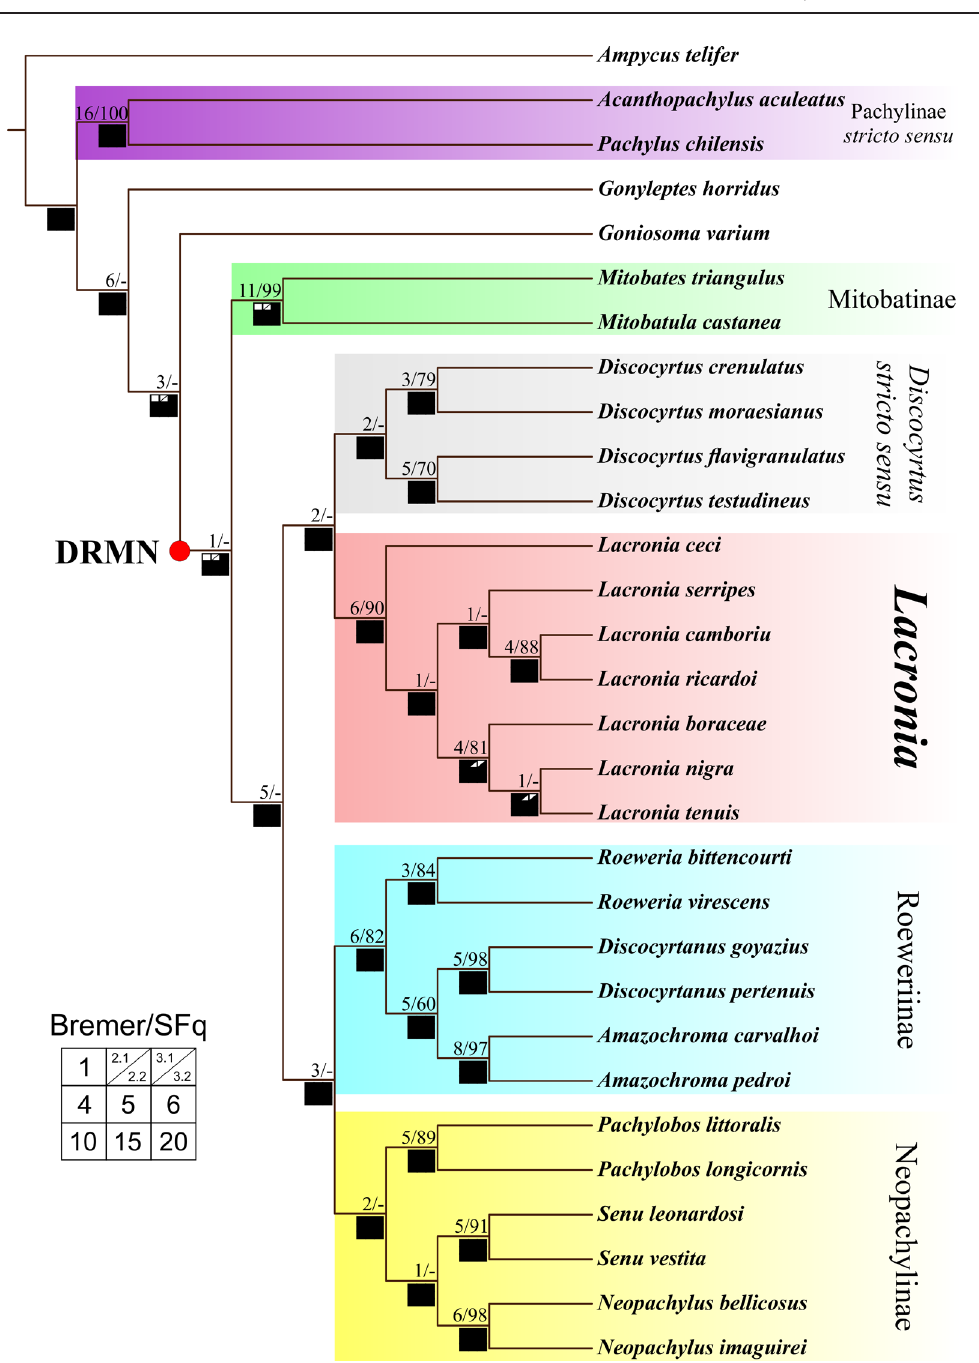
Fig. 1. The most frequent tree (k-values = 3, 4, 5, 6, 10, 15 and 20) retrieved using the Mendes (2011) protocol. Clade support values are indicated above the branches (Bremer index / SFq values). Clade stability is indicated below the branches by the sensitivity plots (‘Navajo rugs’), which denotes the tested k-values (black squares indicate monophyly; white squares indicate non-monophyly). The k-values (= 2 and 3) retrieved two different trees, represented here as 2.1, 2.2, 3.1 and 3.2. in the Navajo rugs. Colored backgrounds indicate the following groups: Discocyrtus Holmberg, 1878 s. str. (grey), Lacronia Strand, 1942 (salmon), Mitobatinae Simon, 1879 (green), Neopachylinae Carvalho & Kury, 2020 (yellow), Pachylinae Sørensen, 1884 s. str . (purple) and Roeweriinae Carvalho & Kury, 2018 (blue). A red circle marks the DRMN-group. The unmarked groups are not members of either DRMN or Pachylinae s. str